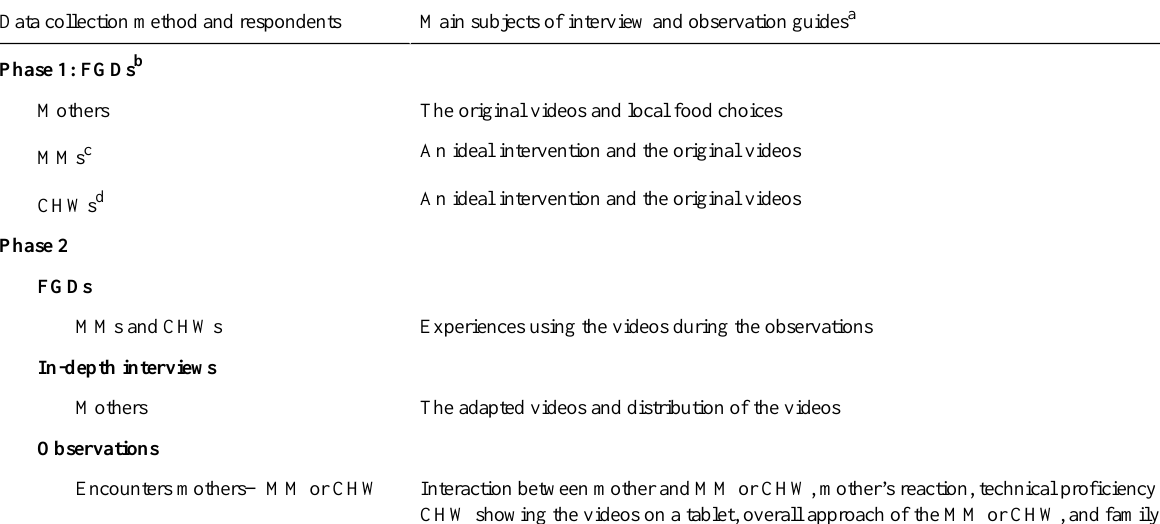
Table 4. Data collection method and main subjects of interview and observation guides.